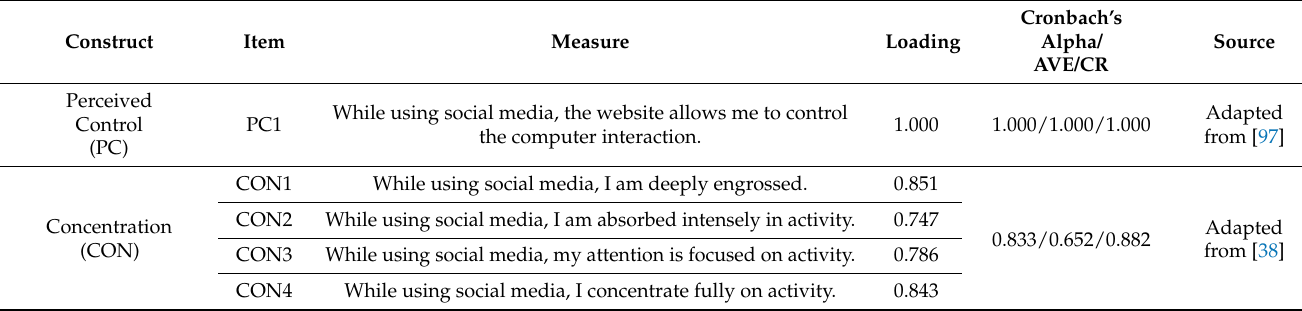
Table 2. Constructs and